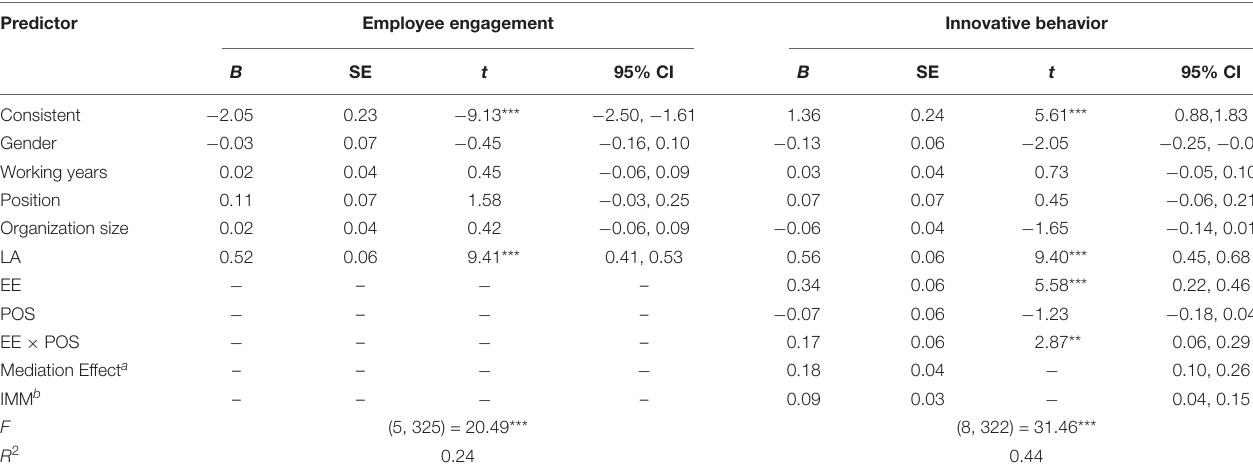
N = 331. Gender (0 = male, 1 = female); Working years (0 = under 5 years, 1 = 5–9 years, 2 = 10–14 years, 3 = 15–19 years, 4 = over 20 years); Position (0 = associate, 1 = manager, 2 = director); Organizational size (0 = under 300, 1 = 300–999, 2 = over 1,000). LA, learning agility; EE, employee engagement; POS, perceived organizational support; IB, innovative behavior; Values in italics denote a HTMT ratio. *p < 0.05, **p < 0.01. TABLE 2 | Regression result for the moderated mediation model.